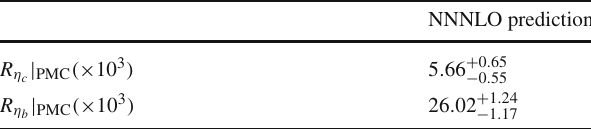
Table 4 The predicted NNNLO R η with known NNLO PMC pQCD series, in which the errors are